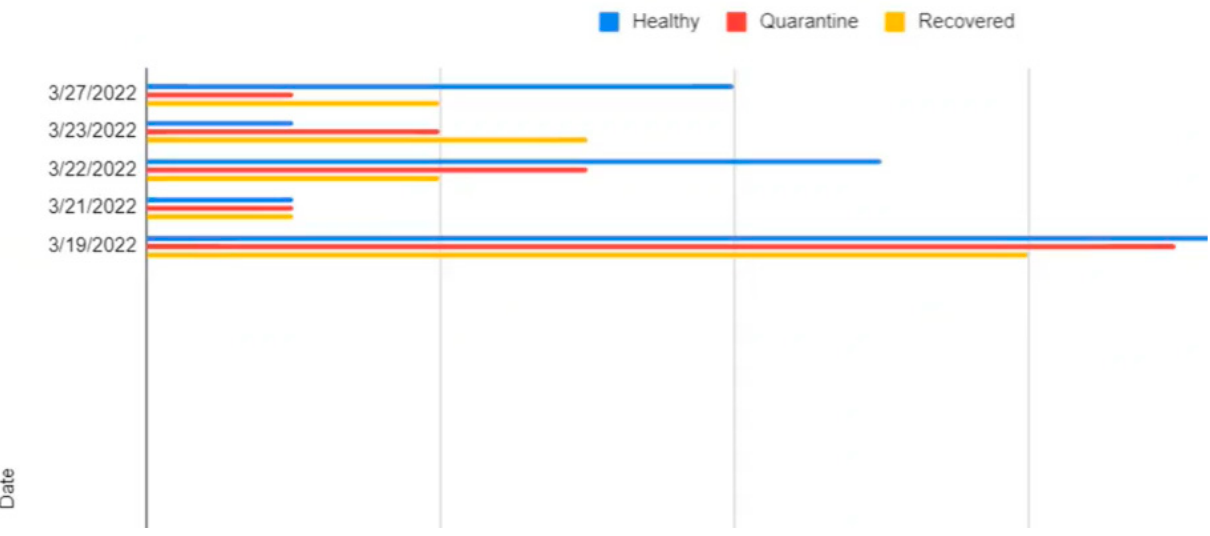
Figure 9. Information sheet for daily analysis of recorded data .